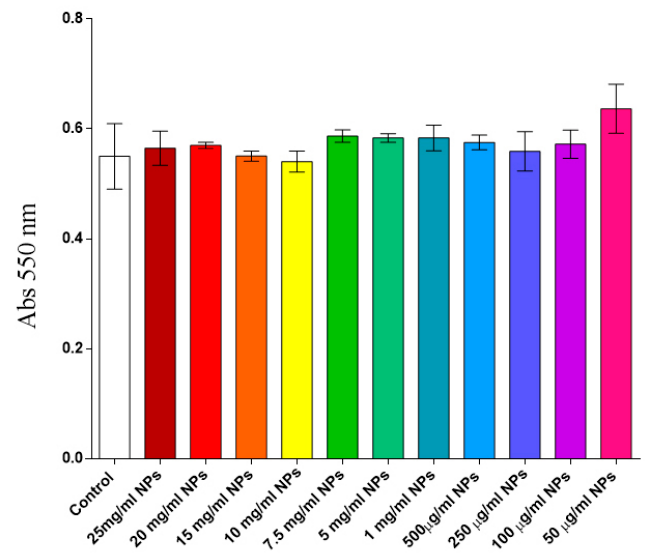
Figure 6. Graphical representation of MCF7 breast cancer cells viability after 24 h of treatment with pristine PNIPAM/magnetite NPs as shown by MTT assay (absorbance values at 550 nm).